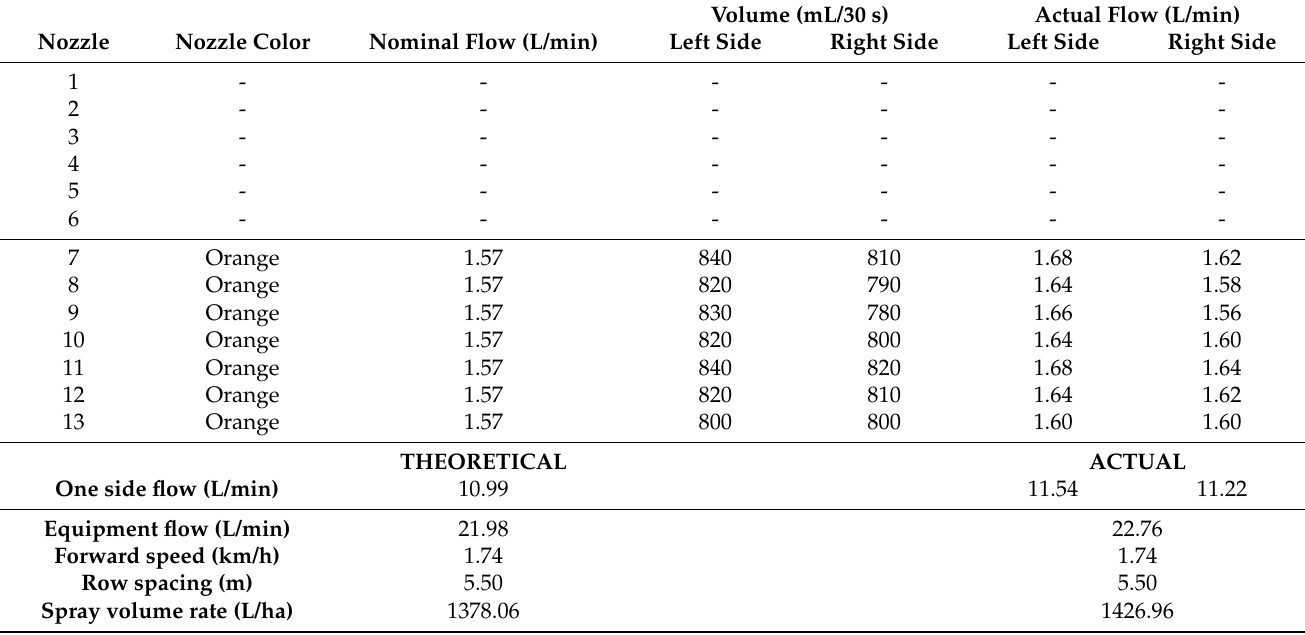
Table A18. Selection and calibration of nozzles for the C1 sprayer, with the following configuration: No adjusted to the vegetation/High & Low fan speed/Low spray volume rate/Conventional nozzles (Fine)/Pressure: 13